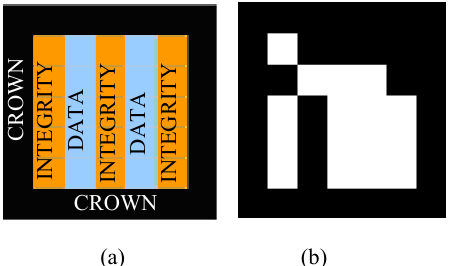
Figure 4 – (a) Codification scheme of an ARUCO target and (b) and example of a